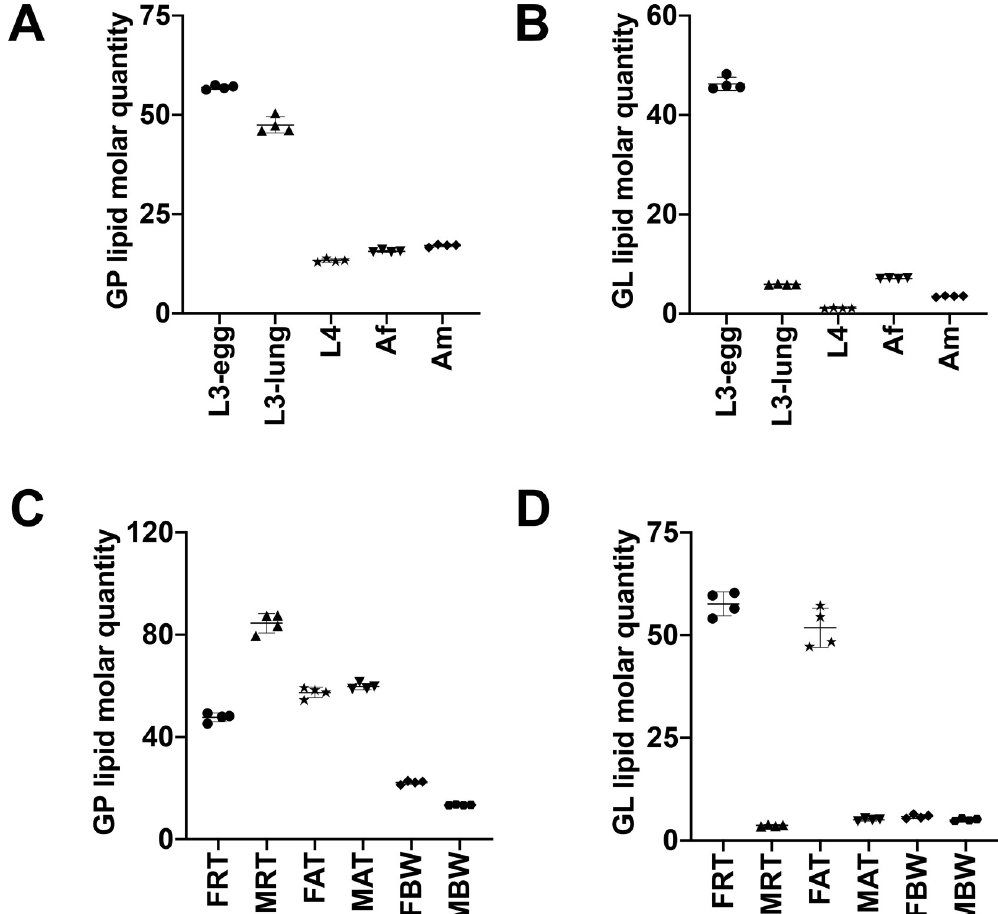
Fig 5. Quantitative differences in glycerophospholipids (GP) and glycerolipids (GL) categories among developmental stages/sexes (A and B) and among adult organ systems (C and D) of Ascaris suum . The five developmental stages/sexes studied were: infective third-stage (L3-egg), lung stage L3 (L3-lung) and fourth-stage (L4) larvae; female (Af) and male adults (Am). The six adult organ systems studied were: the reproductive (FRT) and alimentary (FAT) tracts and body wall (FBW) of female adults; the reproductive (MRT) and alimentary (MAT) tracts and body wall (MBW) of male adults. Semi-quantitative analysis of lipid species, reported as the amount of lipid per mg of dry weight ( μ M/mg). Statistical analysis was performed by ANOVA ( � P < 0.05). Error bars indicate ± SD (four replicates). (141 μ M/mg) had > 4 times more lipid overall as compared with MBW (32 μ M/mg). Except for the reproductive tract, a comparisons of the same organ system between the sexes showed that the female worm had more total lipids than the male. Similar to the developmental lipi- dome, GP (ranged 27–134 μ M/mg) and GL (ranged 3–49 μ M/mg) were the two most abun- dant lipid categories in A . suum at an organ system level, whereas only small amounts (range: 1–11 μ M/mg) of lipids of the SP category were detected (Fig 5 and S1 Fig). Regarding the reproductive tract, the overall GP abundance was significantly higher in male (134 μ M/mg) than in female (69 μ M/mg) (Fig 5B). In contrast, GL abundance showed the opposite trend, with significantly higher levels in FRT (49 μ M/mg) than in MRT (3 μ M/ mg) (Fig 5D). A deeper analysis of the lipidomic data set according to organ system revealed differences primarily in the lipids in the PC, PE and TG classes, characterised by a higher abundance of individual PC species (e.g. PC (16:0_20:4), PC (18:0e_20:2), PC (18:1_20:2) and PC (20:1_18:2)) and PE species (e.g. PE (O-18:0_18:1), PE (O-18:0_20:1)) in FRT compared